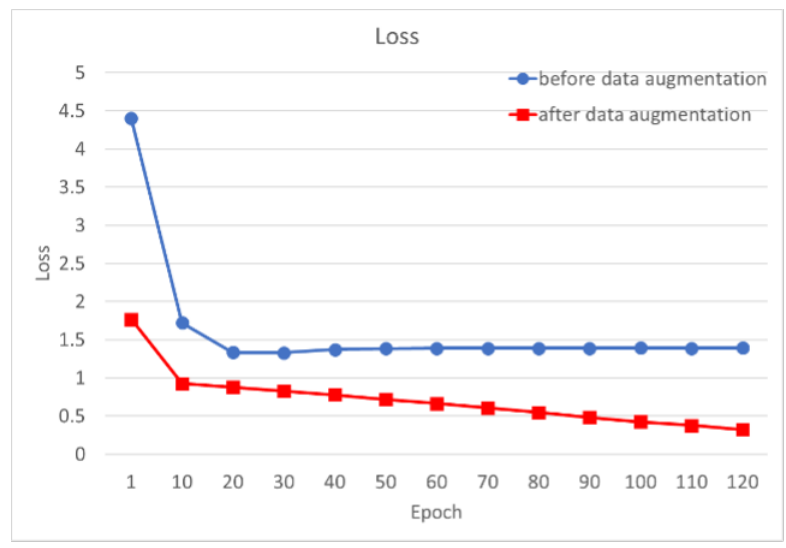
Figure 12. Validation